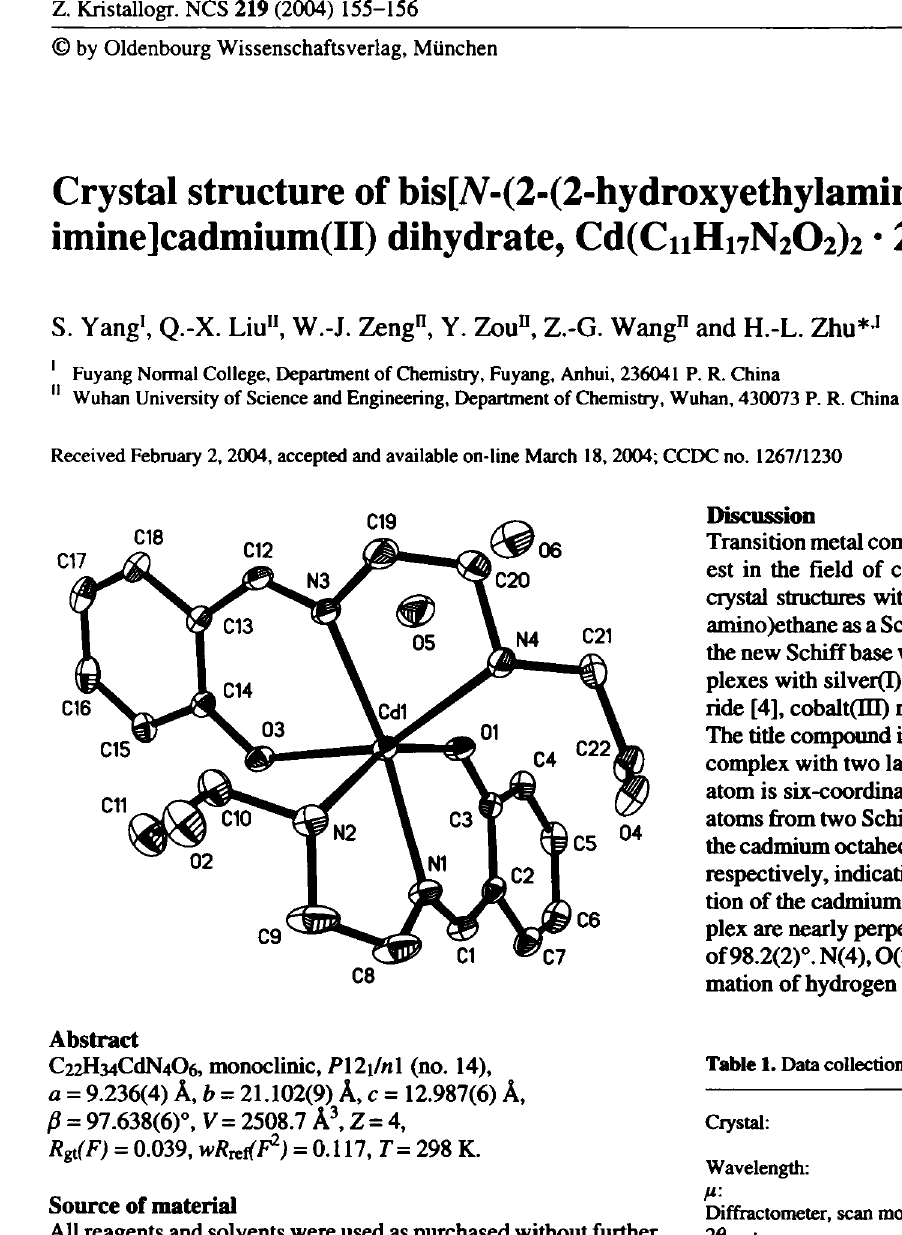
Table 1. Data collection and handling.